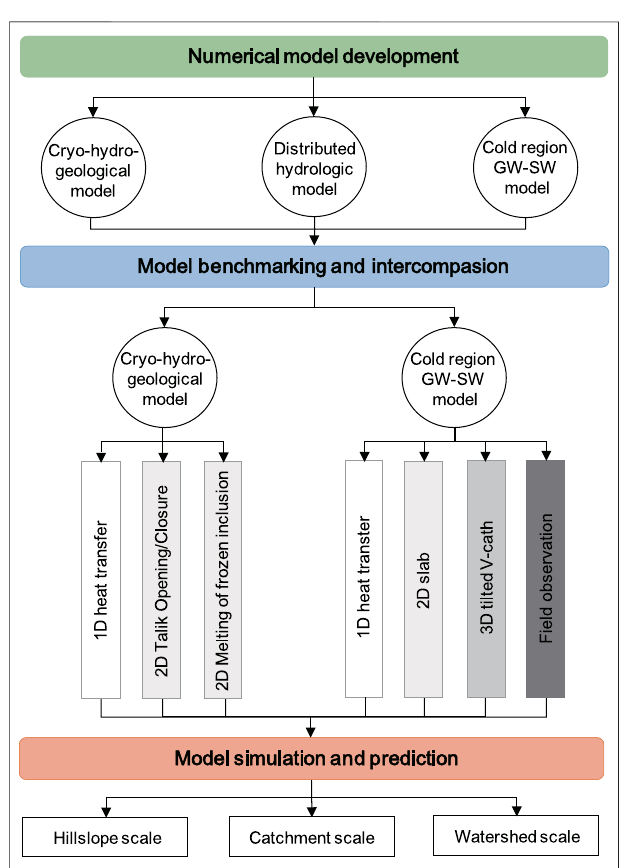
FIGURE 2 | The current research status of modelling GW-SW interactions in cold regions.